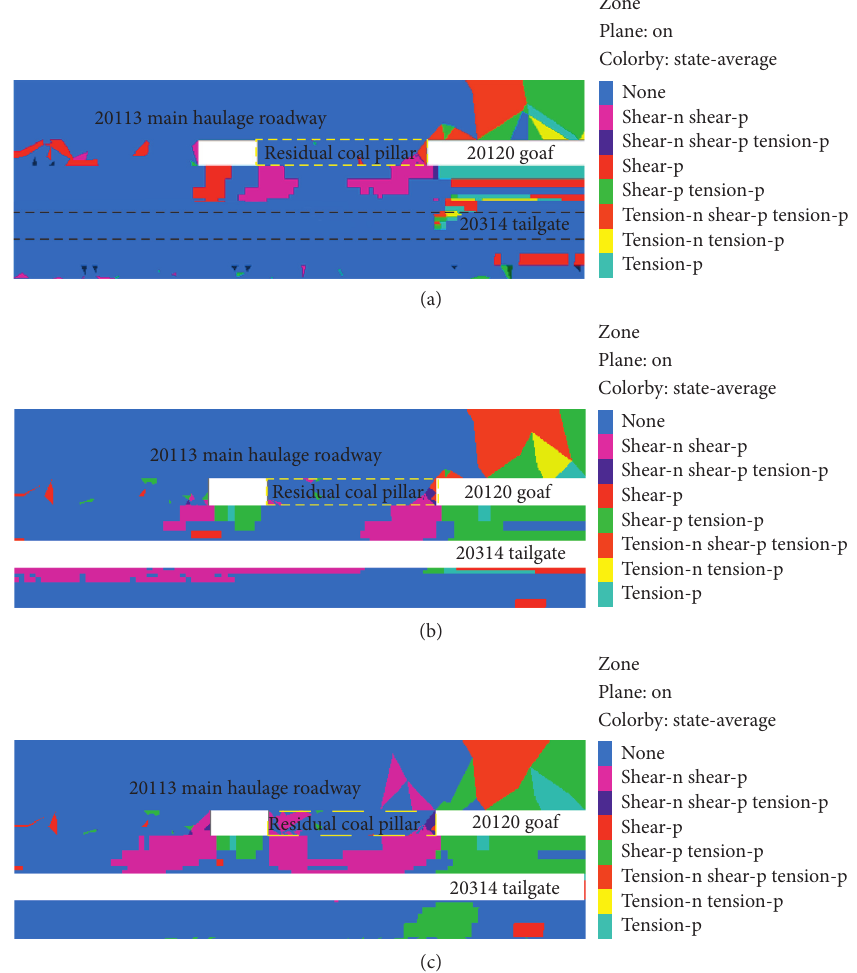
Figure 14: Section variation of the plastic area that is parallel to the 20314 auxiliary haulage roadway (parallel to the axis section of the roadway): (a) 2-2 upper coal seam excavation; (b) 20314 tailgate excavation; (c) 20314 panel